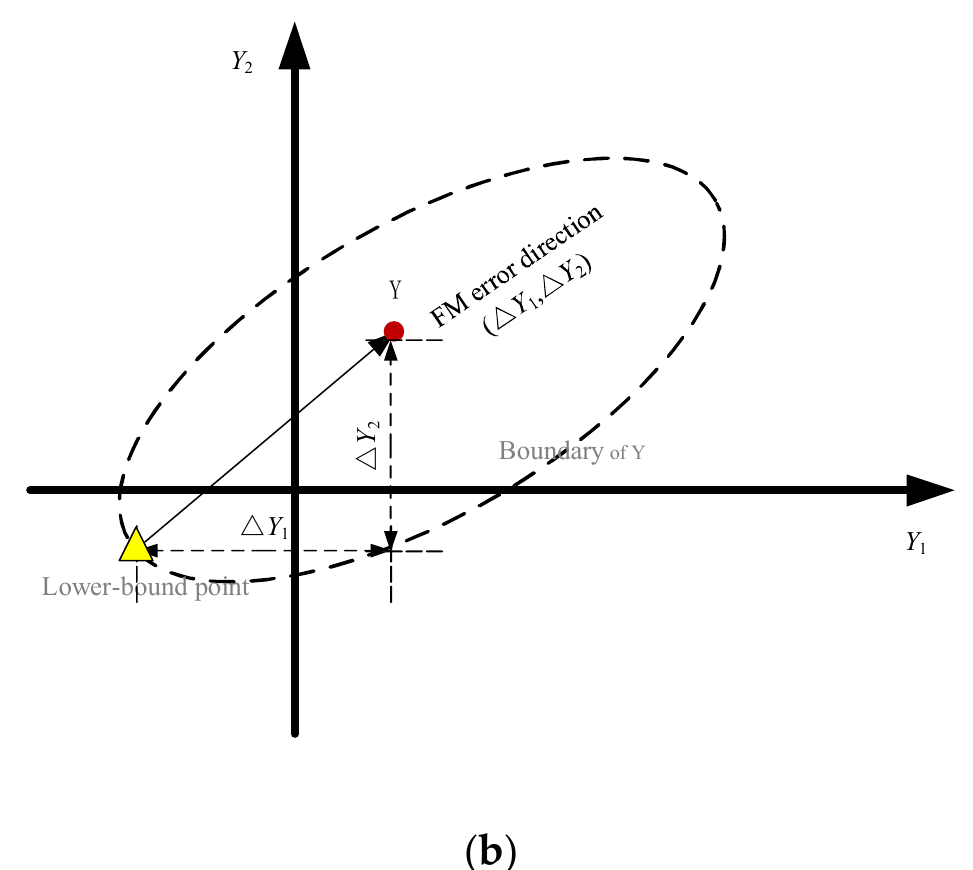
Figure 2. Error value and error direction of FM. ( a ) describes the FM error value in 1D space, and ( b ) describes the FM error direction in 2D space. The red dot is the Y or Y F value corresponding to a specific FM, and the yellow triangle is the statistically or computed lowest value of Y or Y F .